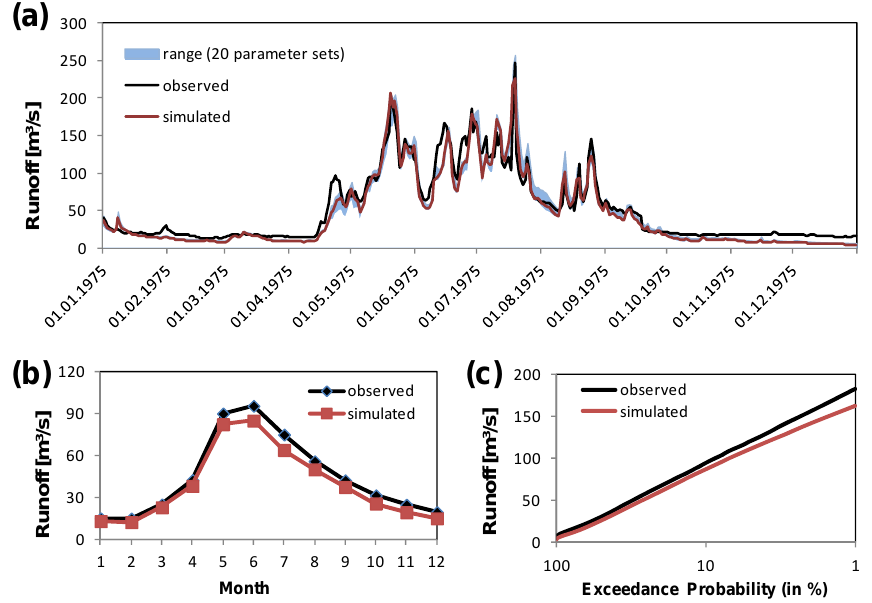
Fig. 4. (a) Observed and HQsim simulated runoff for the year 1975. The blue shading indicates the range obtained when using 20 different parameter sets. (b) Mean monthly runoff and (c) exceedance probability distribution for observed and simulated data, based on the period from 1971 to 2005.